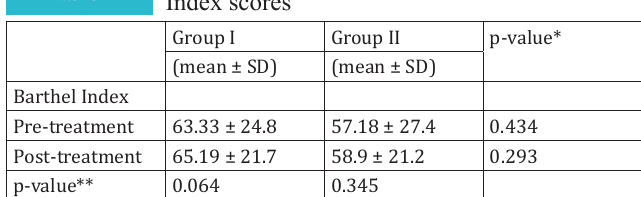
Intra- and intergroup comparisons of Barthel Index scores